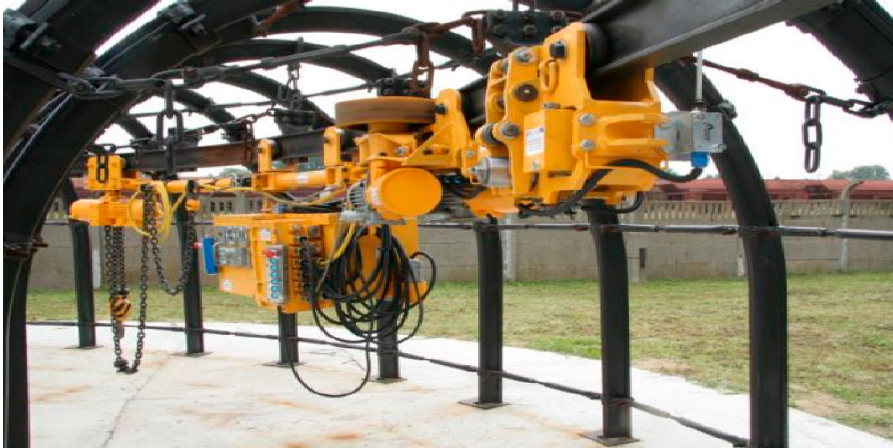
Figure 3. Operation of a suspended battery vehicle (PCA-1).